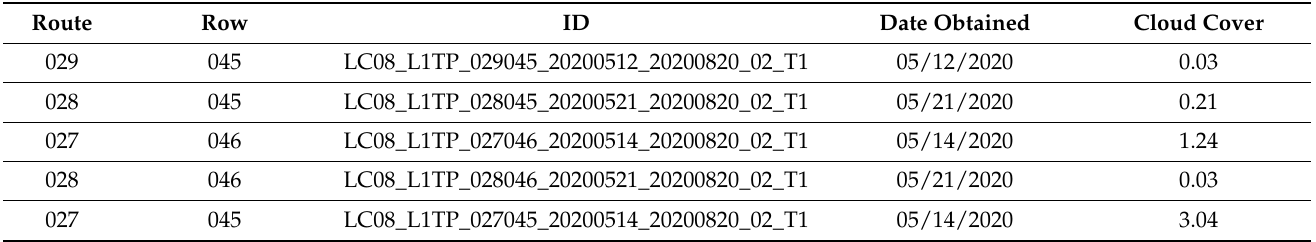
Table 1. Characteristics of Landsat Data Corresponding to the El Baj í o Region, May 2020.